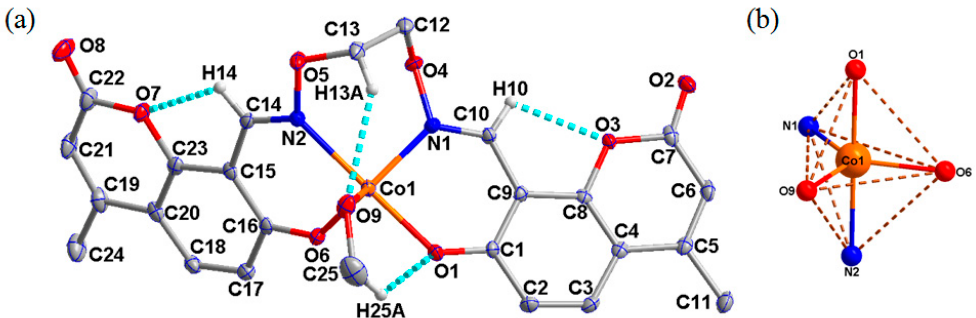
Figure 7. ( a ) X-ray crystal structure and atom numbering of complex 2 with 30% probability displacement ellipsoids; ( b ) Coordination polyhedron for Co(II) atom of complex 2 .